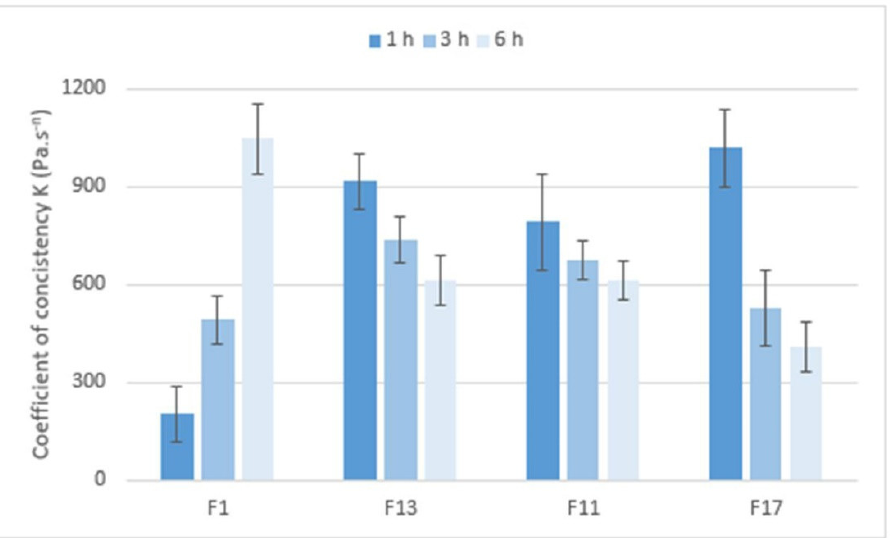
Figure 8. The values of the coefficient of consistency K (Pa. s n ) for matrix tablets F1, F11, F13, and F17.